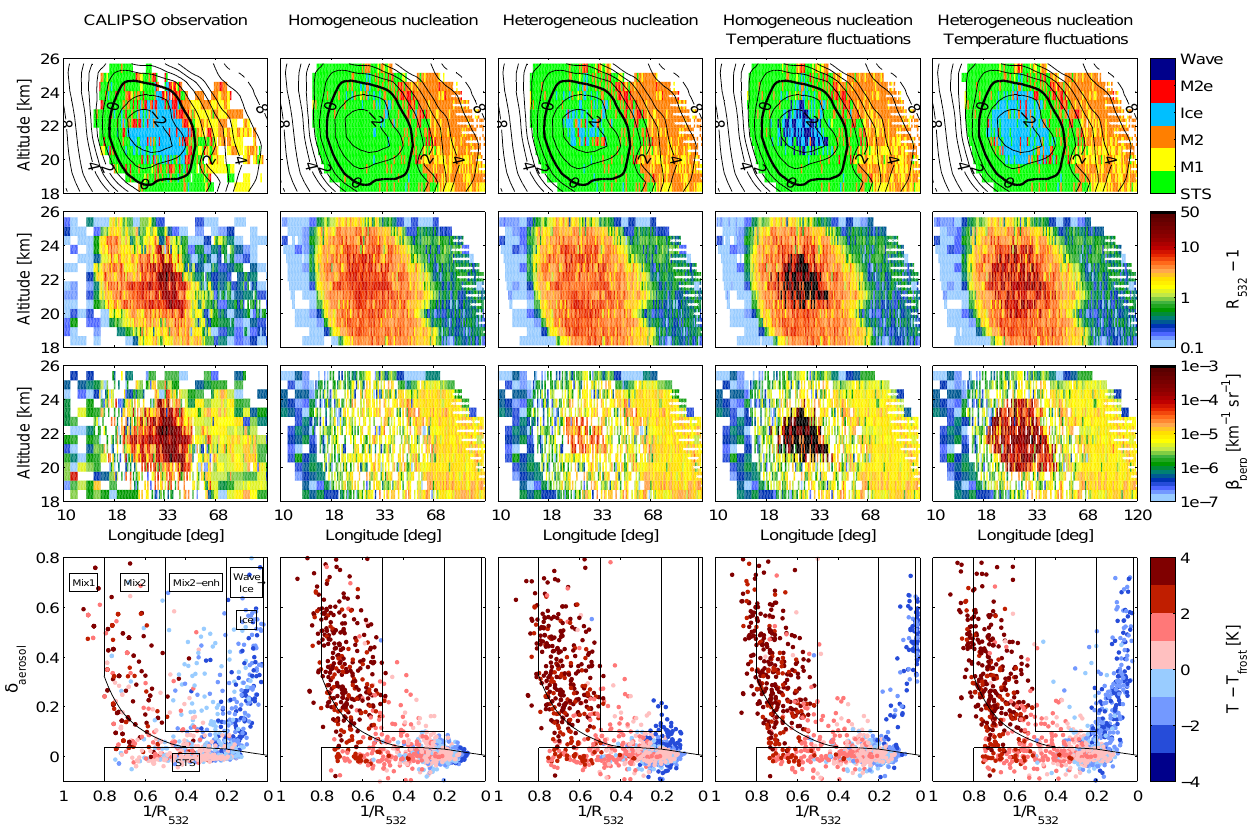
Fig. 5. Orbit 1 on 18 January 2010: CALIPSO orbit track 2010-01-18T01-58-53Z. CALIOP measurements are shown in the first column, model results with varying nucleation mechanism and trajectory temperatures in the subsequent columns. White striped areas indicate trajectories with temperatures below T NAT − 4K longer than 80h or temperatures below T NAT at the trajectory’s starting point resulting in an inaccurate initialization. Contour lines and the color-coded data presented in the lowermost row display ERA-Interim temperatures relative to T frost